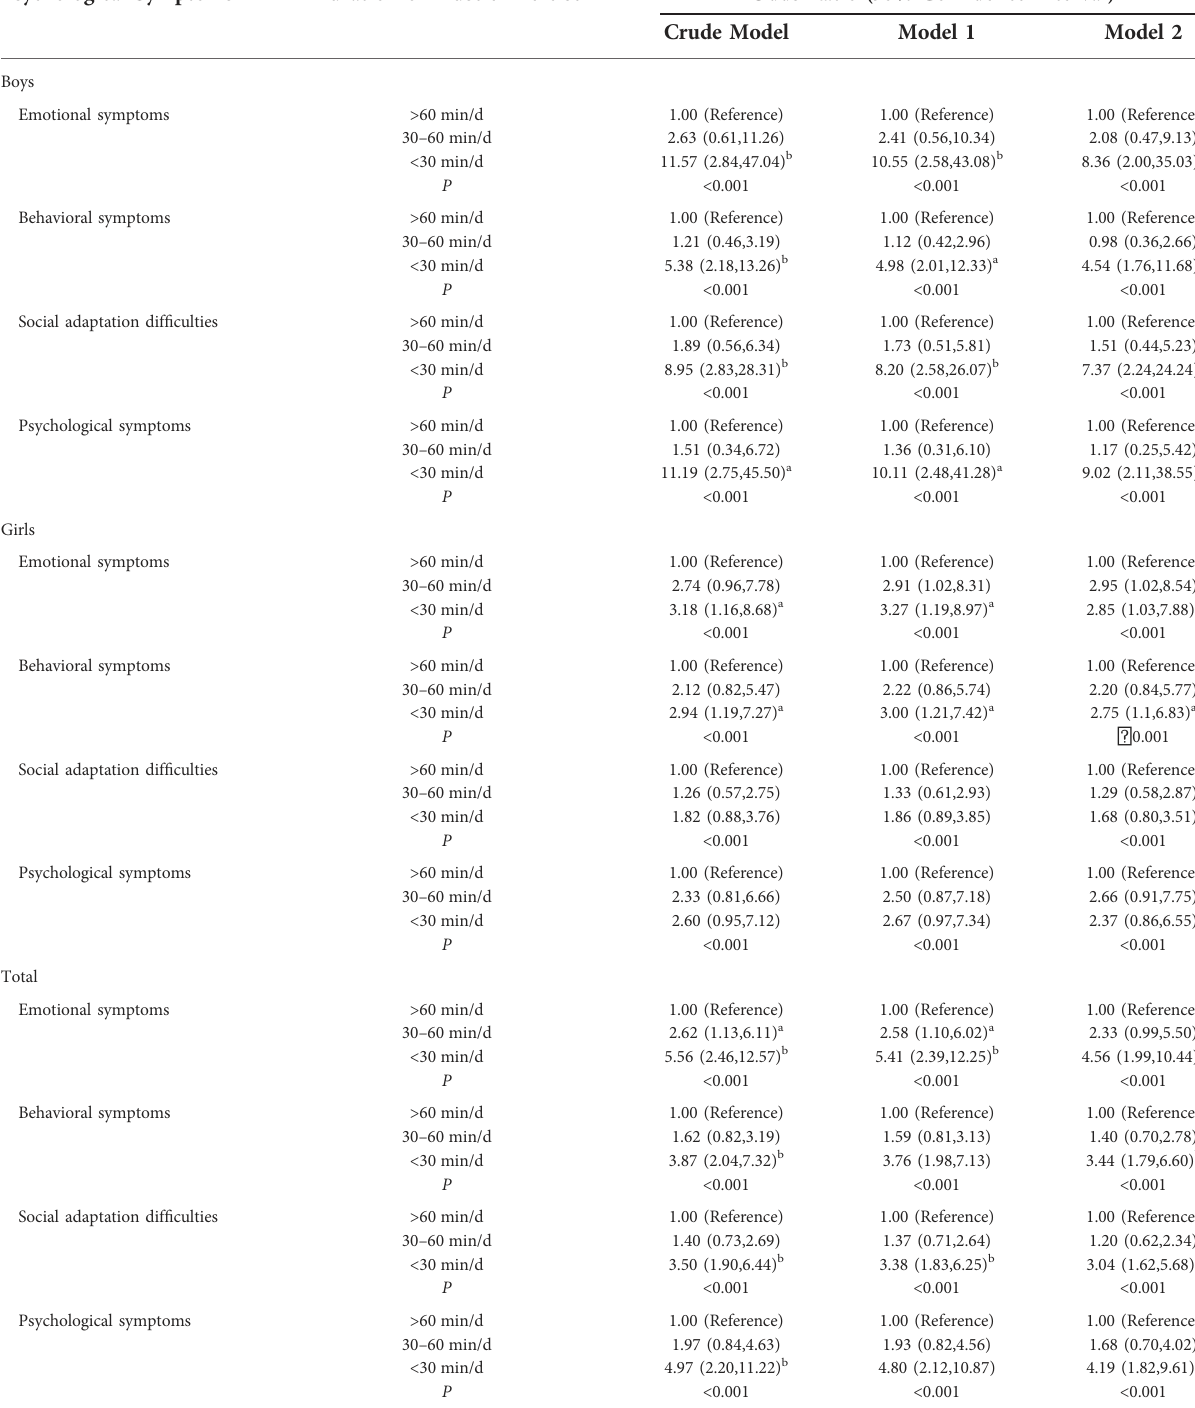
TABLE 3 Logistic regression analysis of duration of muscle exercise and psychological symptoms among Chinese college students ( n